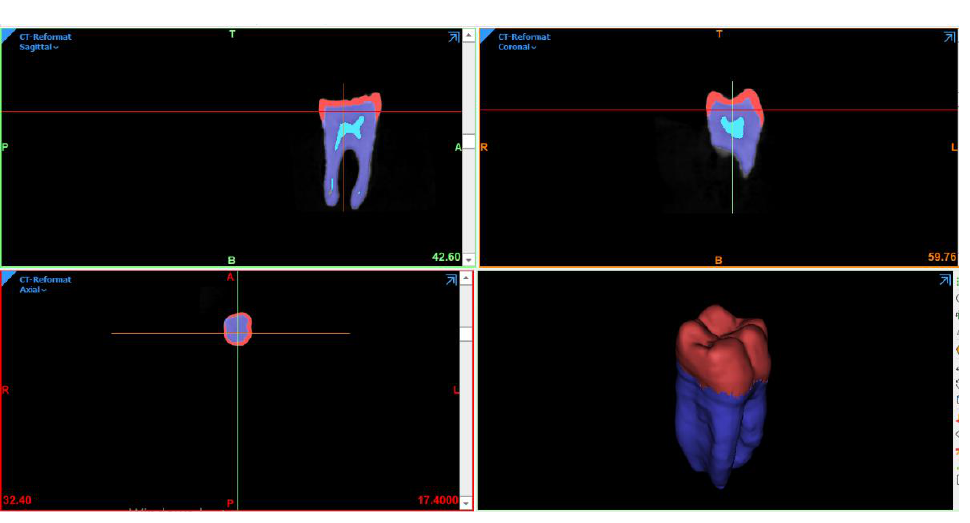
Figure 1. The isolated dental